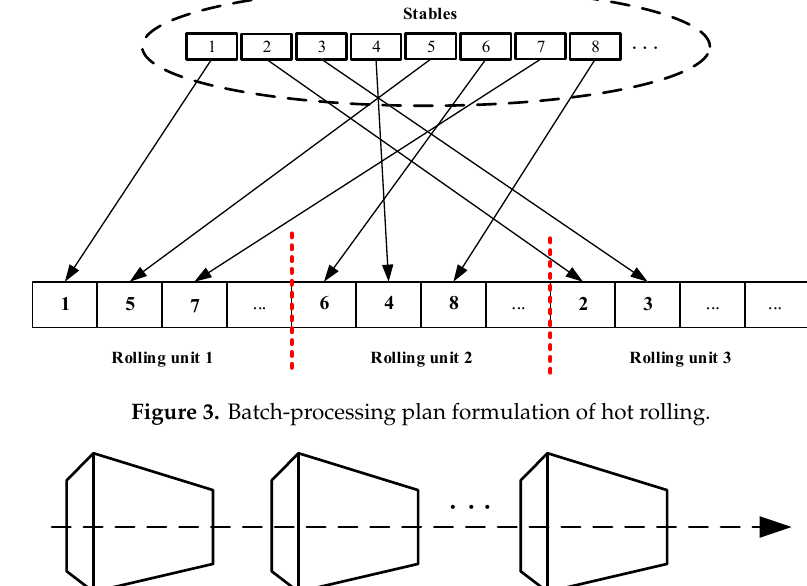
Figure 3. Batch-processing plan formulation of hot rolling.